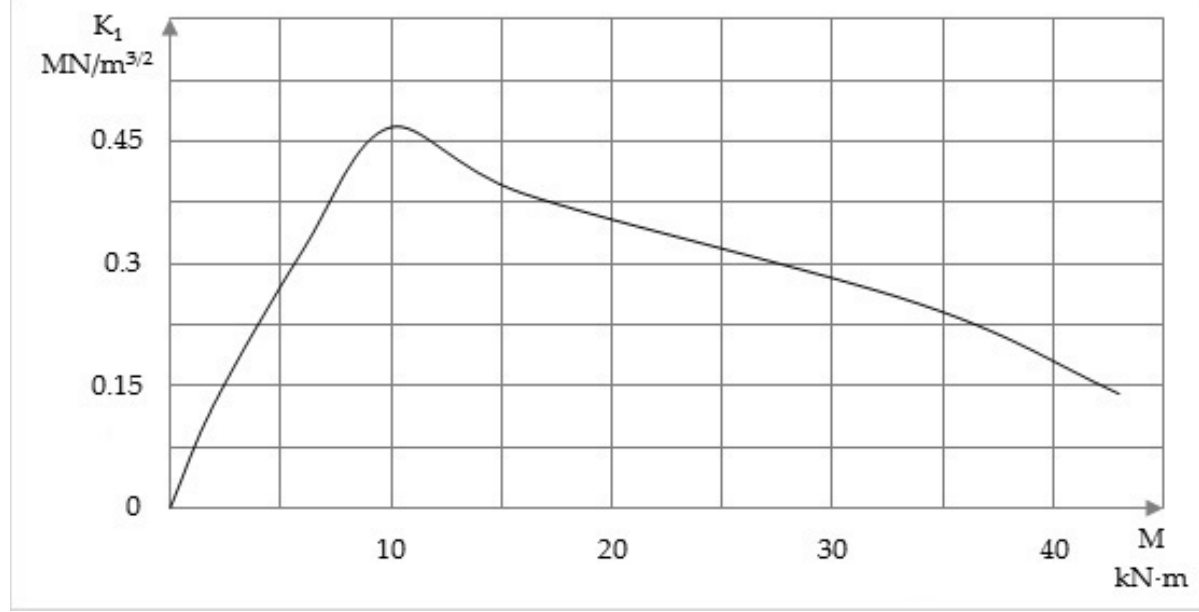
Figure 6. Change in SIF from external moment.